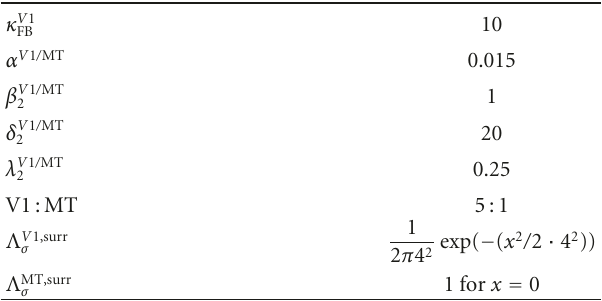
Table 1: Parameter settings for the constants and kernel sizes used in the neural computational